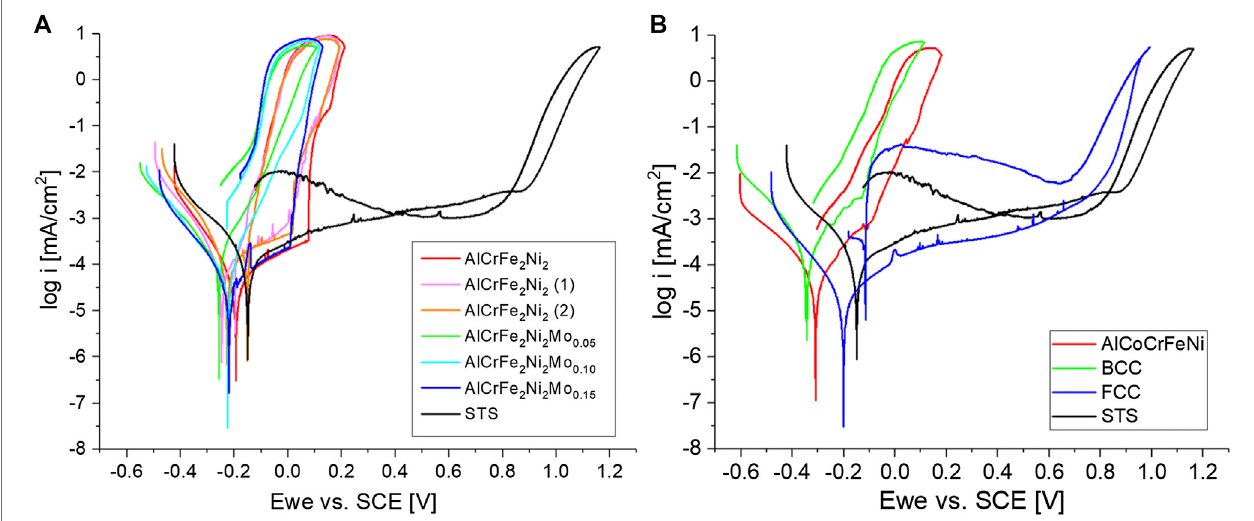
FIGURE 7 | Potentiodynamic polarization curves (Tafel) in 3.5 wt% NaCl for the Co-free alloys and STS (A) , and for three quinary alloys and STS (B) .